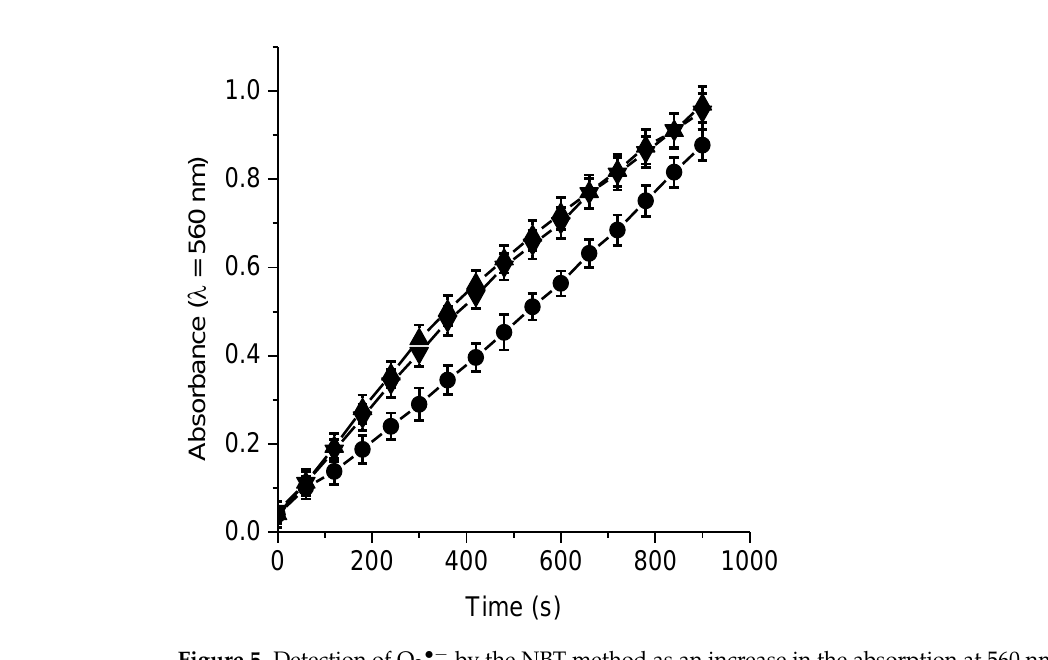
Figure 5. Detection of O 2 •− by the NBT method as an increase in the absorption at 560 nm sensitized by PTPPF 16 -EDA ( (cid:72) ) and PZnTPPF 16 -EDA ( (cid:78) ) in DMF irradiated with white light (44 mW/cm 2 ), [NBT] = 0.2 mM and [NADH] = 0.5 mM. Control of NBT + NADH without PS ( ⚫ ).